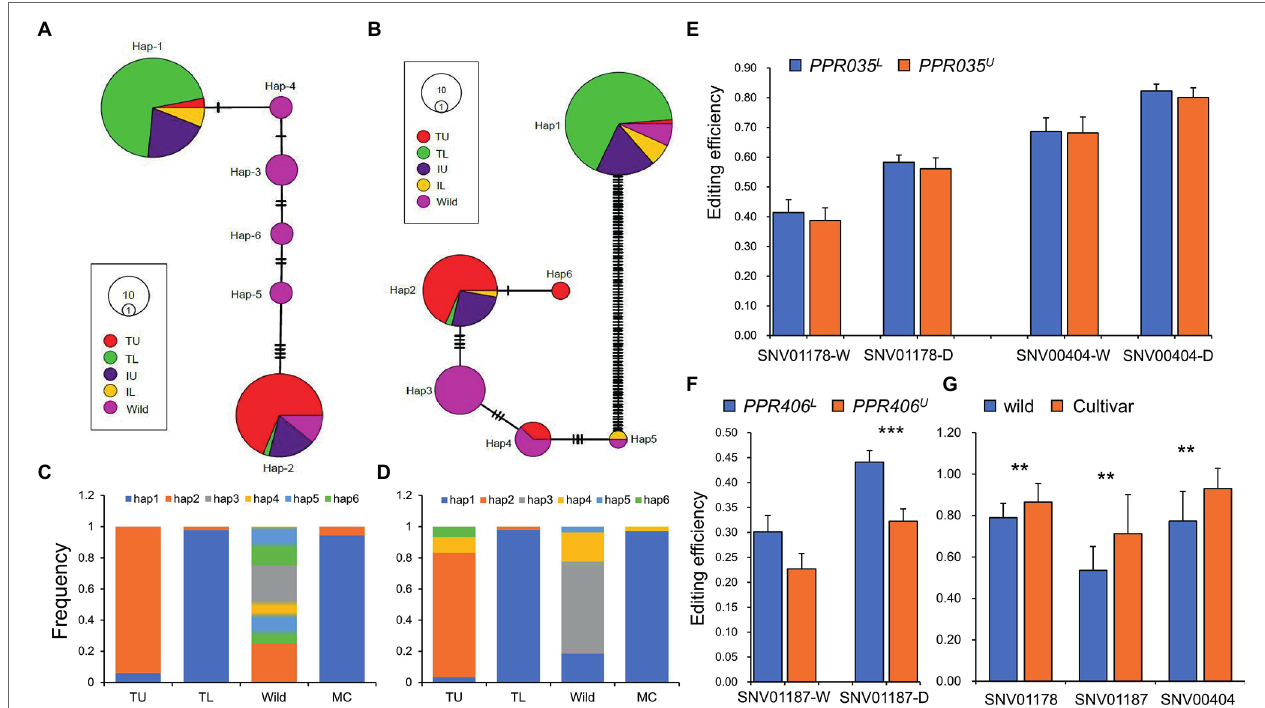
FIGURE 5 | Haplotypes of PPR035 and PPR406 in wild, landraces, and modern cultivars. (A) Haplotype network of PPR035 in wild rice, upland rice, and lowland rice. (B) Haplotype network of PPR406 in wild rice, upland rice, and lowland rice. (C) The frequency of six major haplotypes of PPR035 in wild rice, landraces, and modern cultivars (MC). (D) The frequency of six major haplotypes of PPR406 in wild rice, landraces, and modern cultivars. (E) Editing efficiencies at the PPR035 regulating sites in upland- and lowland-dominant haplotypes ( PPR035 U and PPR035 L ). (F) Editing efficiencies at the PPR406 regulating site in upland- and lowland- dominant haplotypes ( PPR406 U and PPR406 L ). (G) Editing efficiencies at related sites in modern cultivar and wild rice. ** and *** indicate significance at p < 0.01 and p < 0.001 by independent t -test. IL, Intermediate lowland rice; TL, Typical lowland rice; IU, Intermediate upland rice; and TU, typical upland